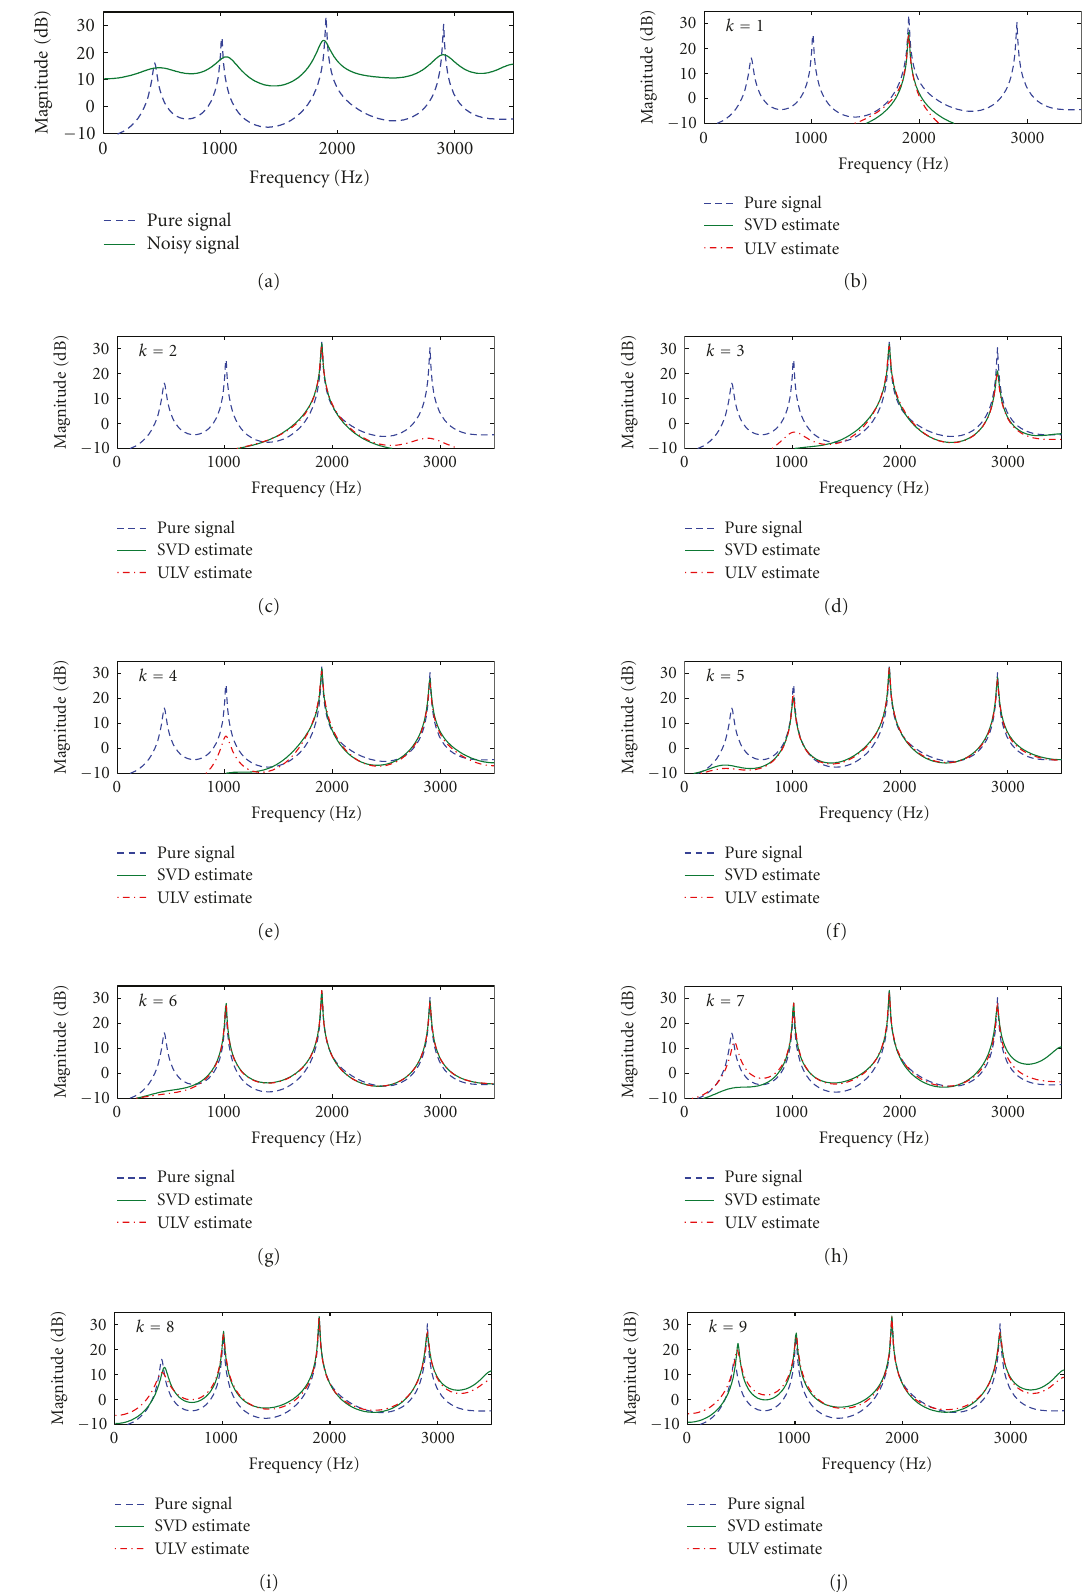
Figure 2: Example with a sum-of-sines clean signal for which H has rank 8, and additive white noise with SNR 0dB. Top left: LPC spectra for the clean and noisy signals. Other plots: LPC spectral for the SVD and ULV LS-estimates with truncation parameter k = 1, ...